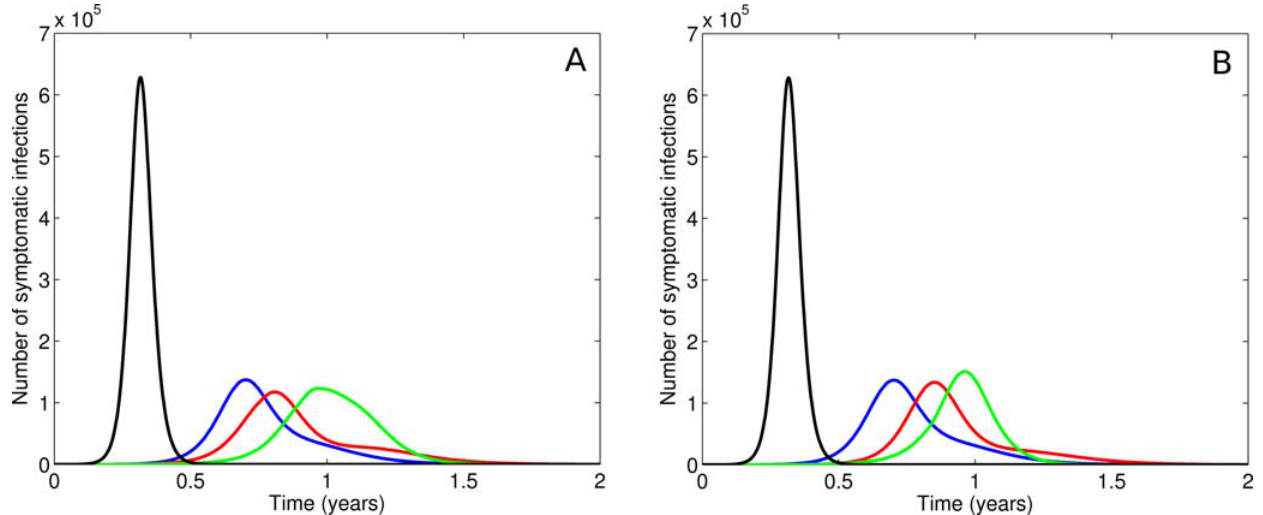
Figure 5. Strategic use of one or two drugs: epidemic curves. a. Epidemic curves for no intervention (black), a single drug strategy (blue), a random allocation strategy (red) and a T&P strategy (green) for a 90/10 stockpile. The T&P strategy provides the longest time to median infection. b. As for Figure 5a but with a 50/50 stockpile.